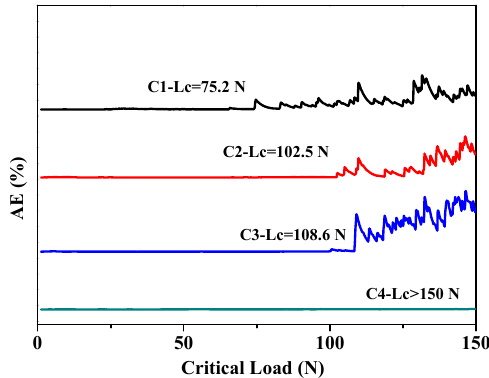
Figure 4. The acoustic signals and critical load of CrN films on 316L substrate.